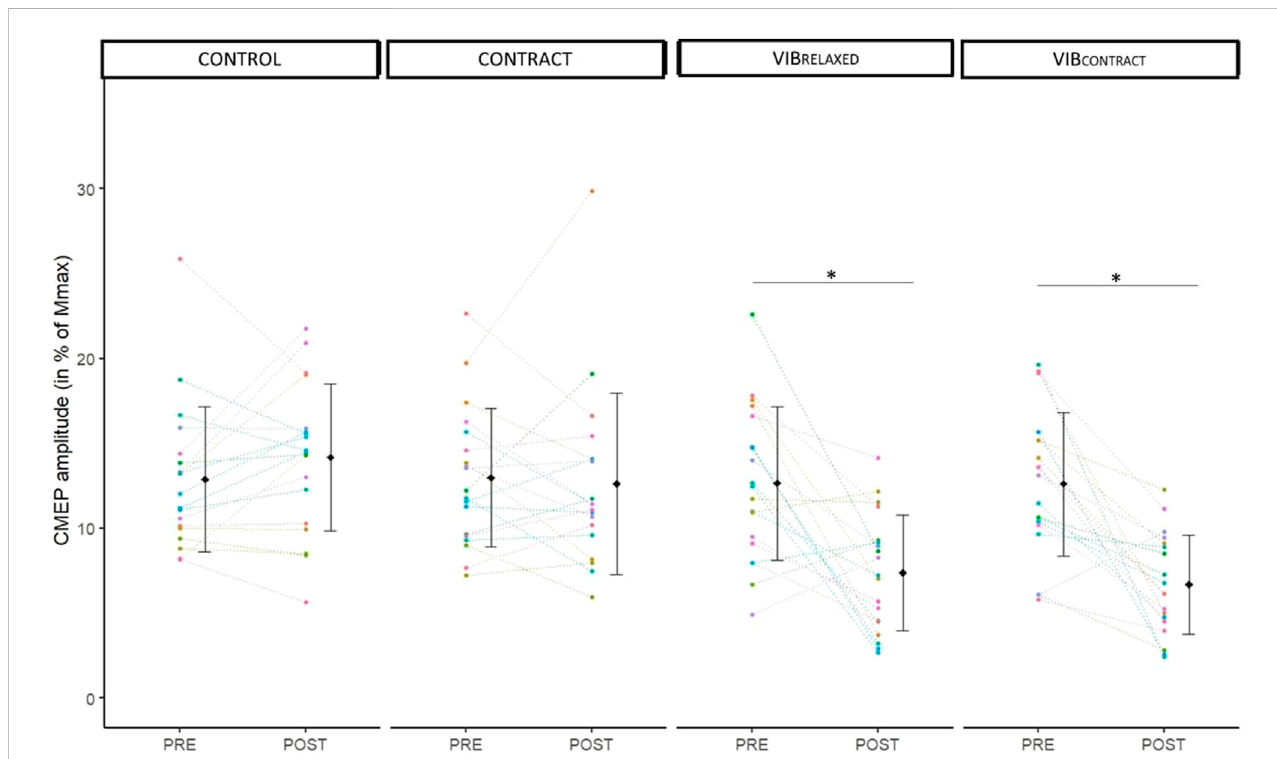
FIGURE 3 Mean and individual CMEP amplitudes in % of Mmax. PRE and POST values are represented for each condition. Each dot represents the value of a participant. * represents signi fi cant differences between PRE and POST.